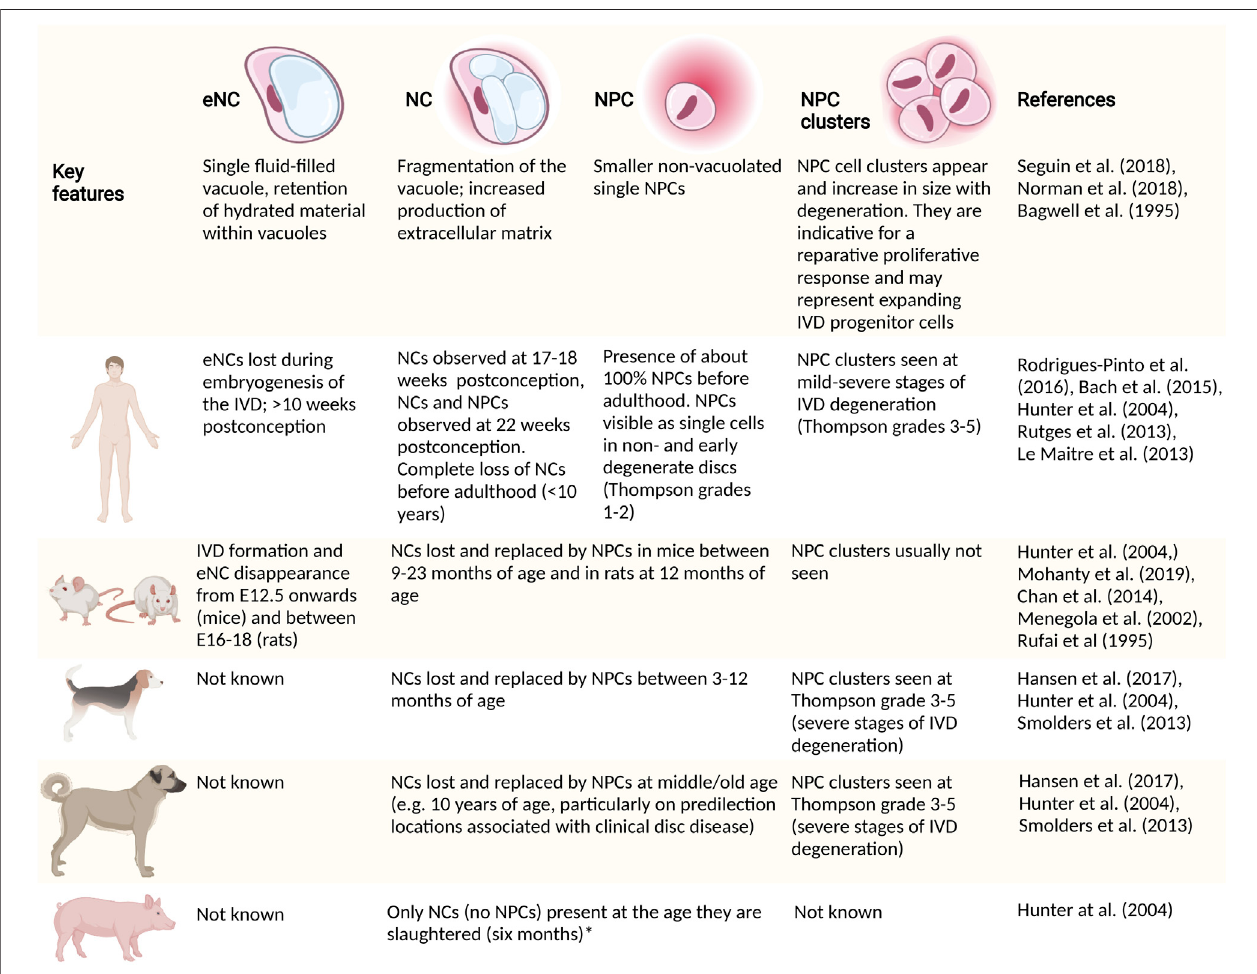
FIGURE 4 | High level differences in embryonic and postnatal cell transitions within the nucleus pulposus (NP). Cellular morphological transitions of the cells in the NP andassociatedinterspeciesvariationinspeciescommonlyusedasmodelstostudyNC(pathobiology)areprovided.Largeanimalmodels,includingsheep,goatsandcows losetheir NCs rapidly after birth (Alini et al., 2008). *, Authors haveevidence that pigs keep their NCs until at least 2 years ofage.CD, chondrodystrophic;E,embryonic day; eNC, embryonic notochord cell; IVD, intervertebral disc; NC, notochordal cell; NCD, non-chondrodystrophic; NP, nucleus pulposus; NPC, nucleus pulposus cell.